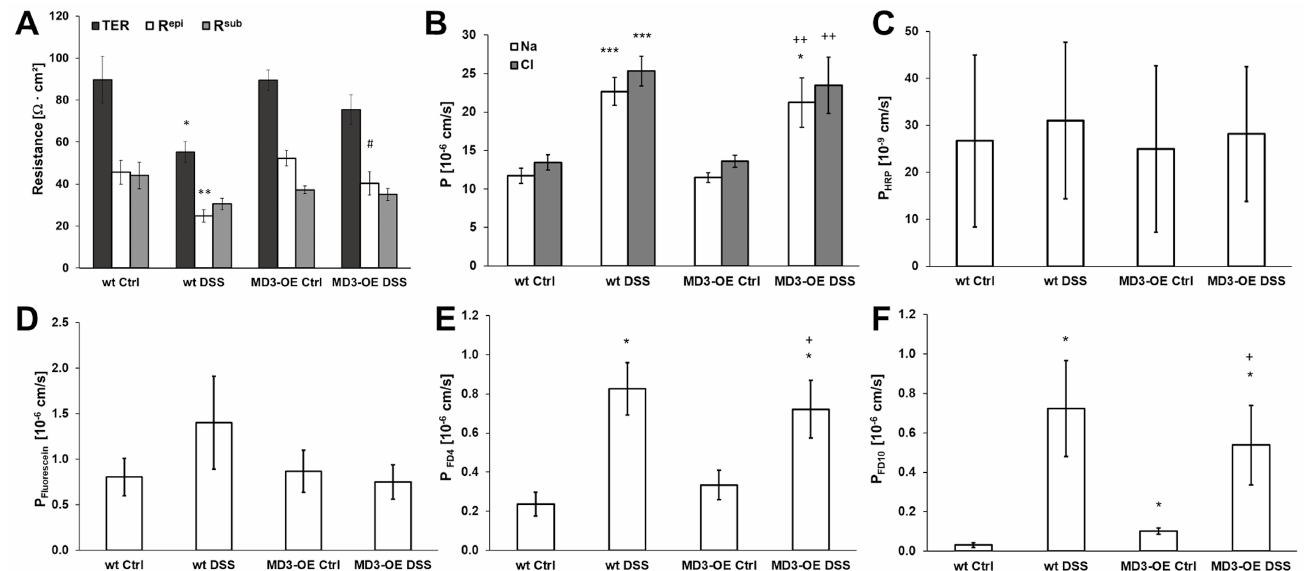
Figure 6. Characterization of functional intestinal barrier properties in wt and MD3-OE mice during DSS-induced colitis. ( A ) Impedance spectroscopic differentiation of the TER in R epi and R sub ( n = 11–13). ( B ) Permeabilities for Na + and Cl- as determined by dilution potentials ( n = 5–13). ( C ) Permeability for the transcellular flux marker HRP ( n = 5–8). ( D ) Permeability for the